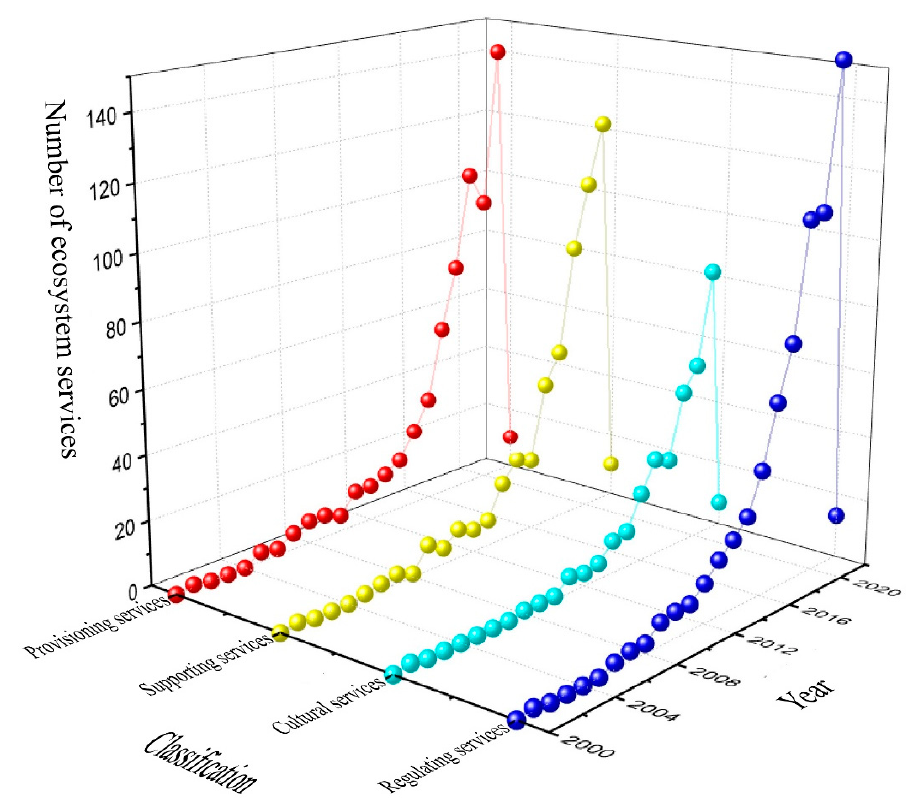
Figure 5. Studies on different types of ecosystem services.